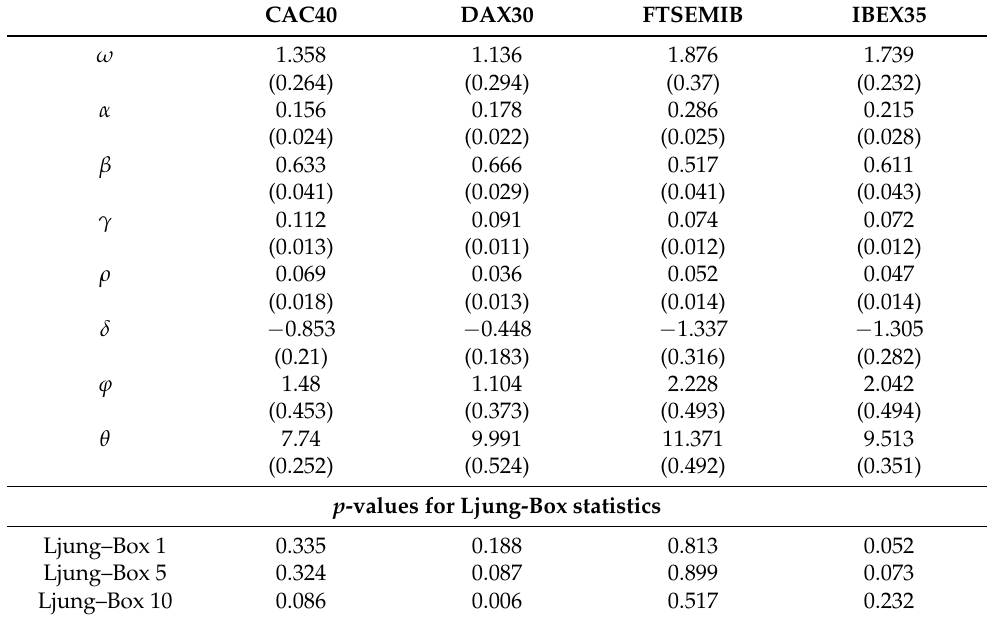
Table 3. Model Estimation results from the AMEMX (robust s.e. in parenthesis) and p -values for the Ljung–Box statistics. Estimation period: 1 June 2009–31 December 2019. Dependent Variable: Realized Volatility.